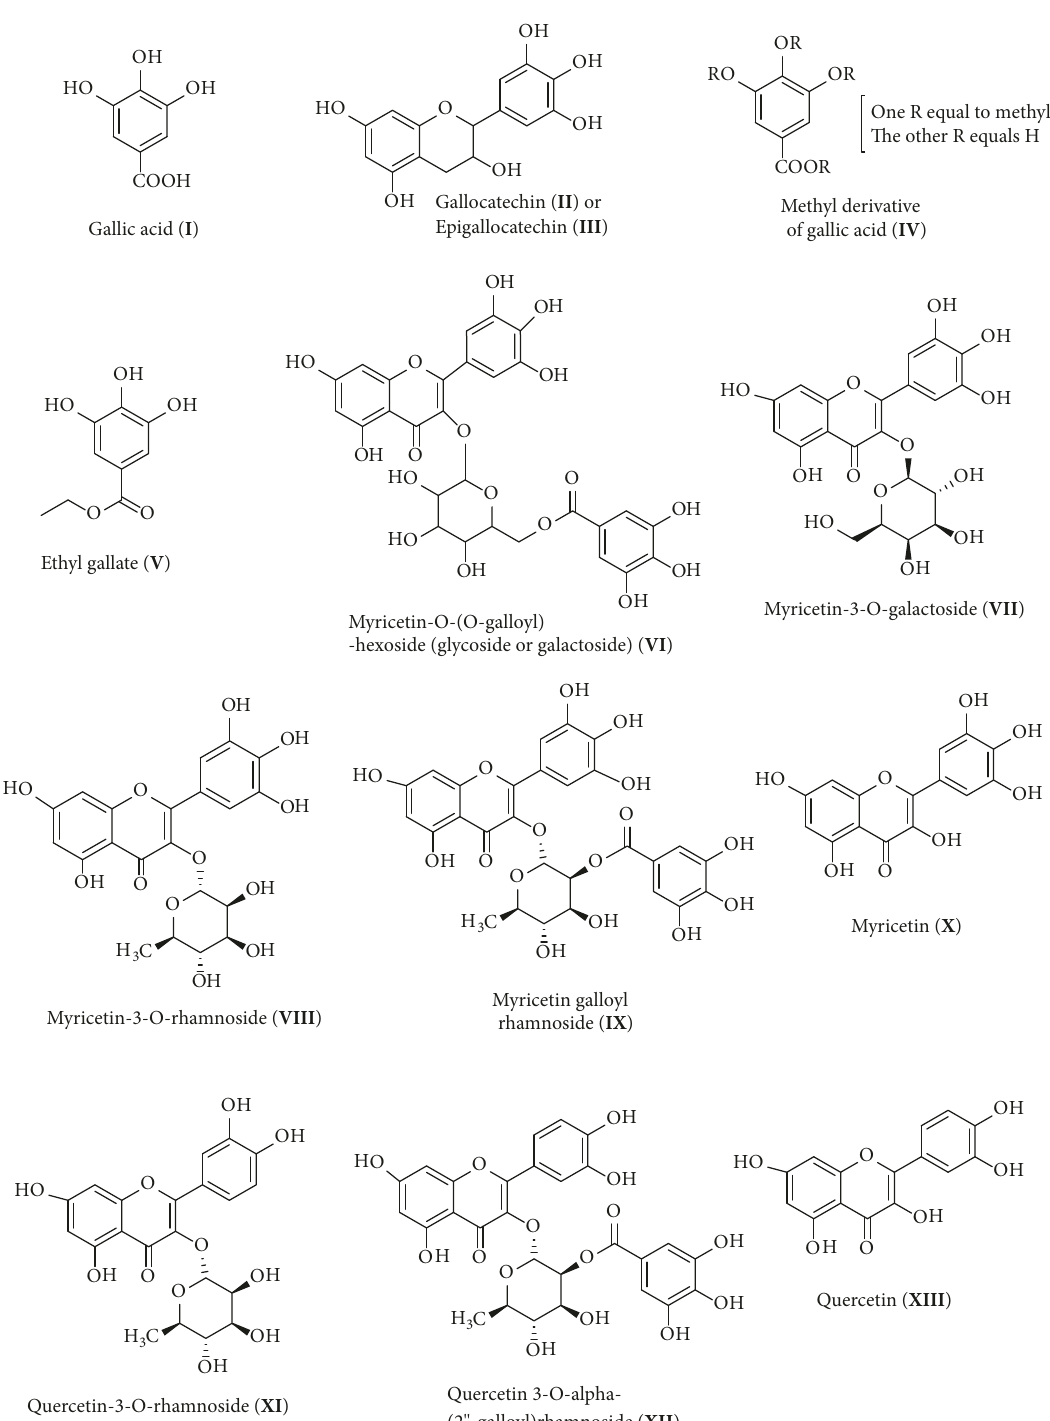
Figure 2: Compounds identified in the